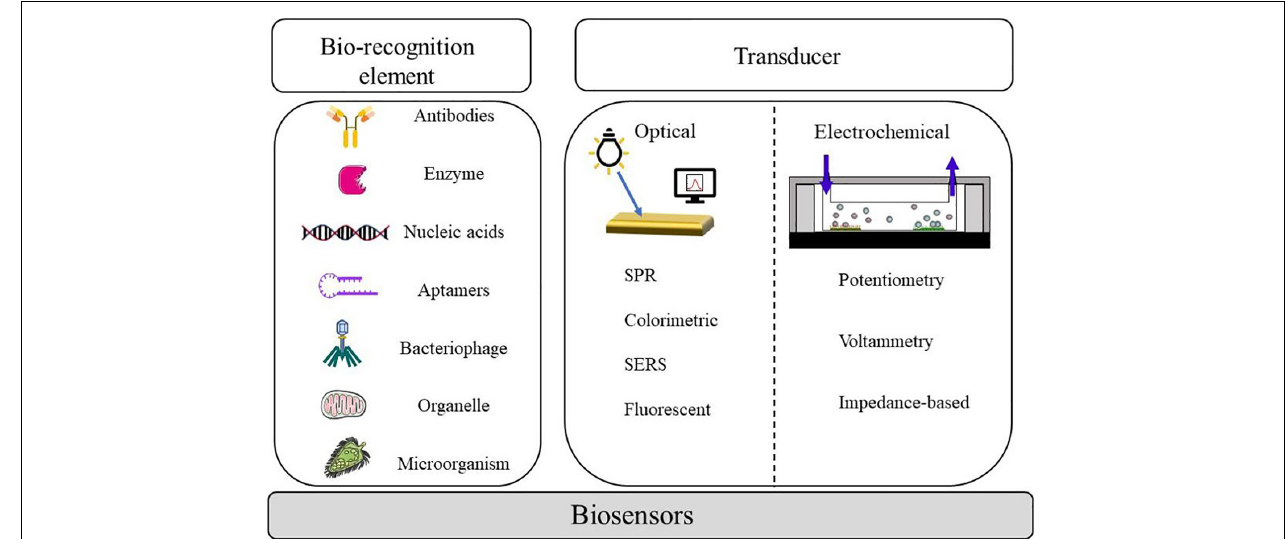
FIGURE 1 | Components and measurement methods associated with biosensors for pathogen